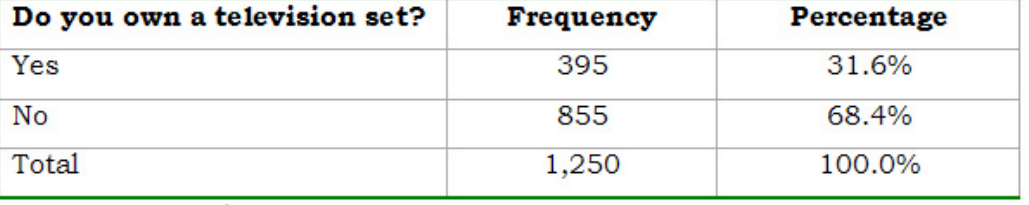
Table 7. Distribution of household ownership of televisions in Nigeria